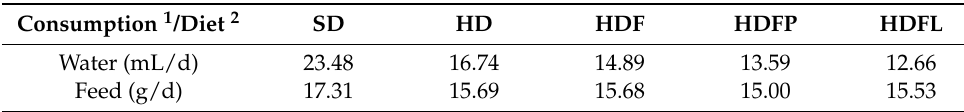
Table 1. Feed and water consumption during the study.